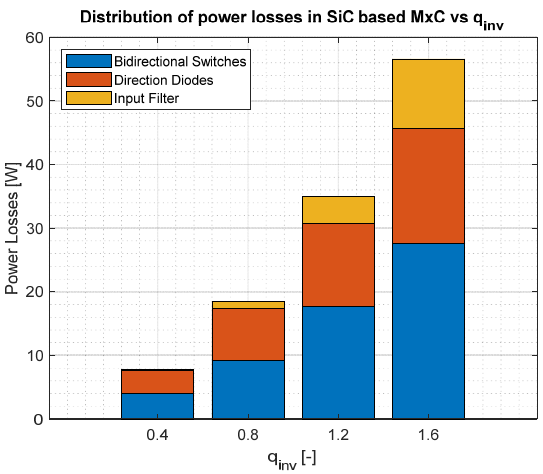
Figure 8. Distribution of power losses in SiC-based MxC.